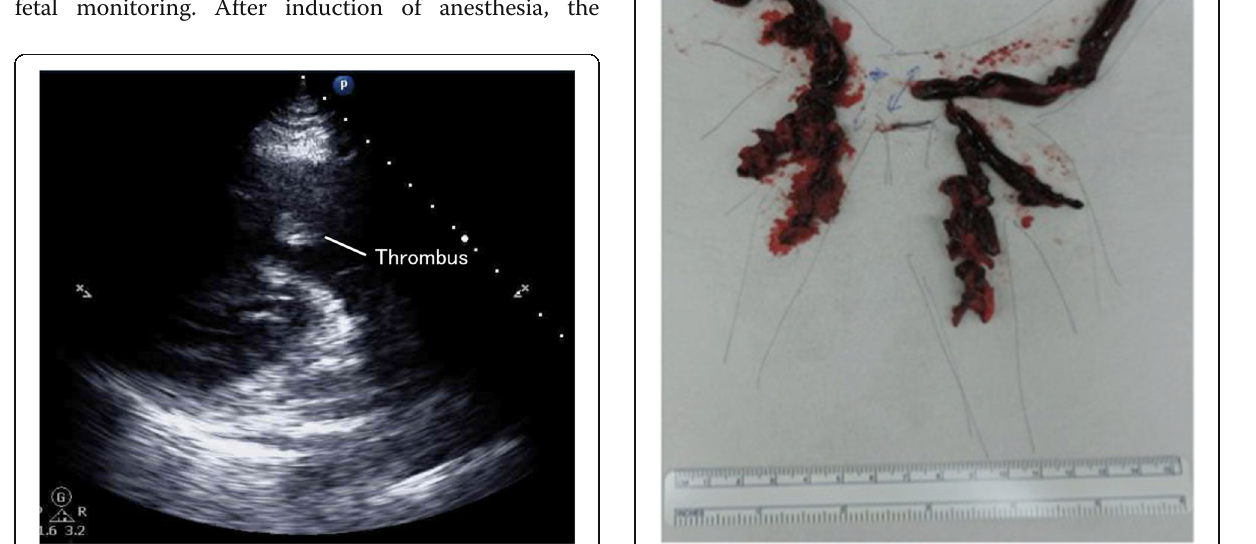
Fig. 2 Transthoracic echocardiography. A mobile thrombus is observed in the right ventricle